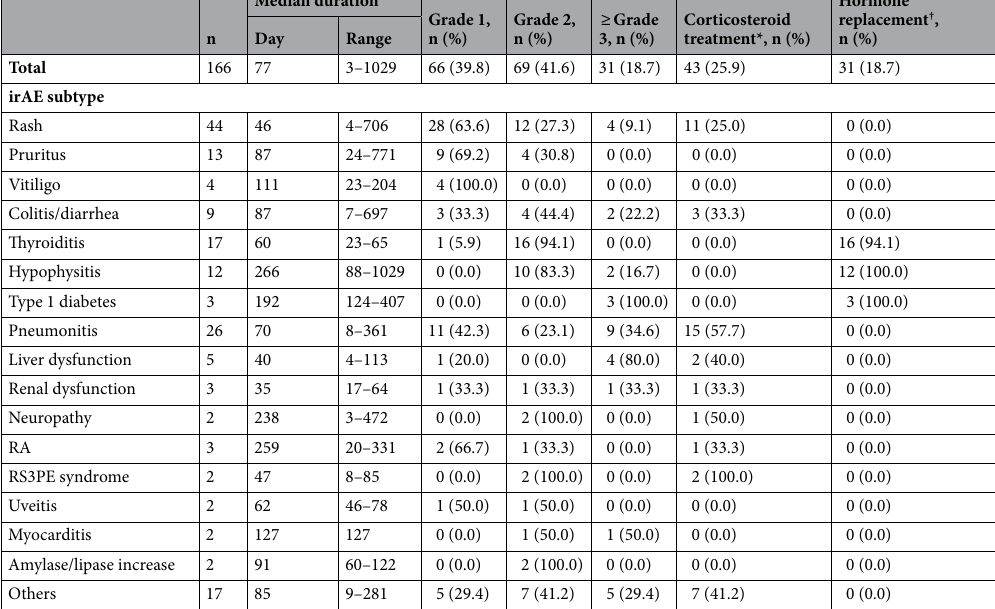
Table 2. Immune-related adverse events of this study population. irAE immune-related adverse events, RA rheumatoid arthritis, RS3PE remitting seronegative symmetrical synovitis with pitting edema. *Corticosteroid includes prednisolone, methylprednisolone, and dexamethasone treatment. † Hormone replacements includes hydrocortisone, levothyroxine, and insulin treatment.